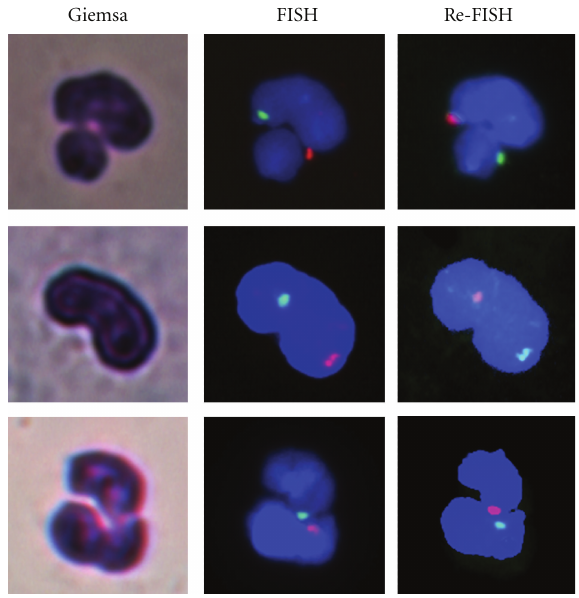
Figure 2: Example of Giemsa, FISH and re-FISH images of three detected